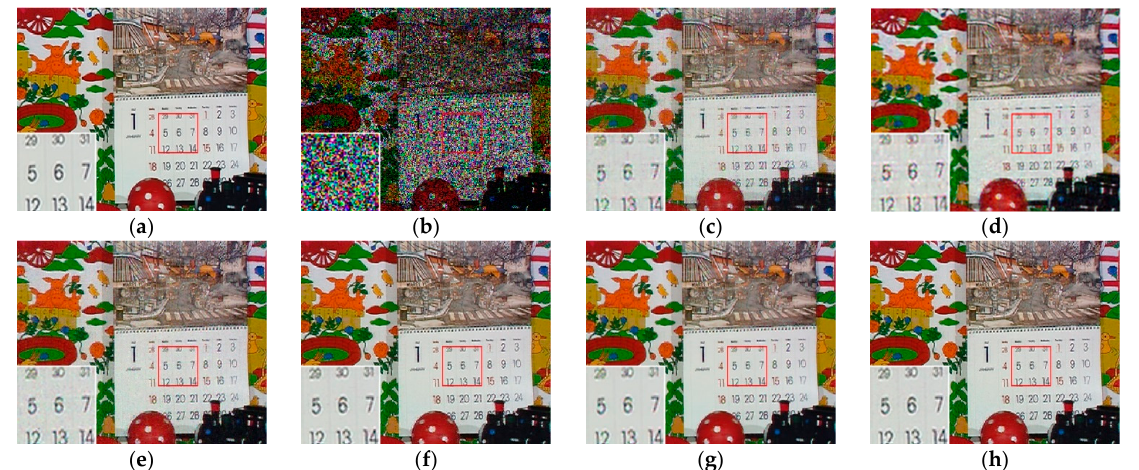
Figure 11. Comparison of the running time.